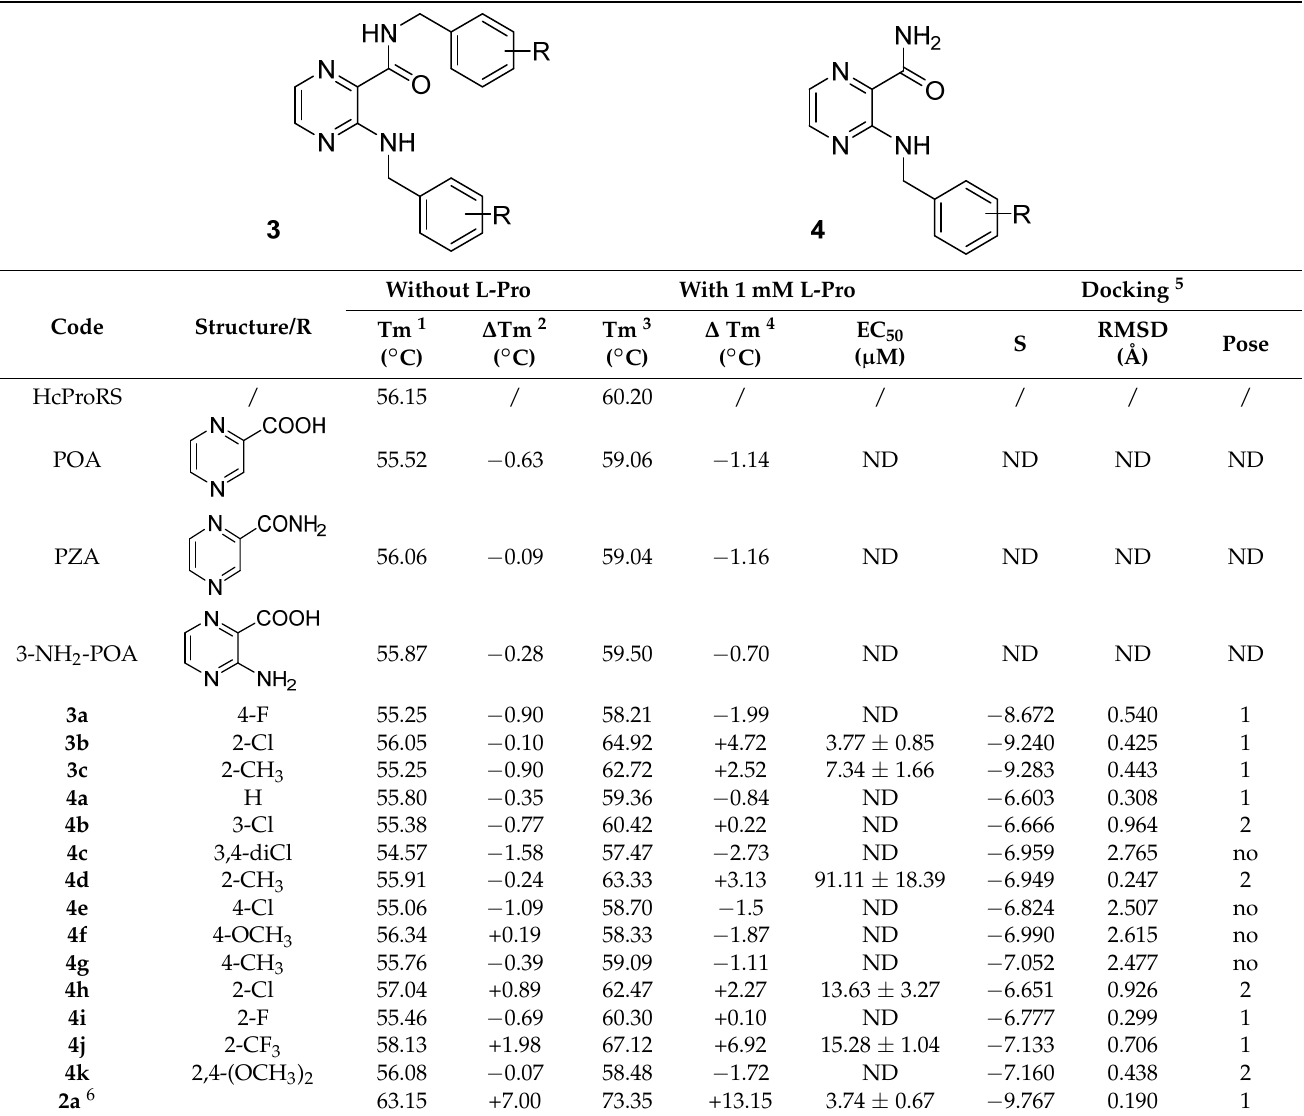
Table 1. The docking scores, thermal stabilization and EC 50 values of studied compounds.